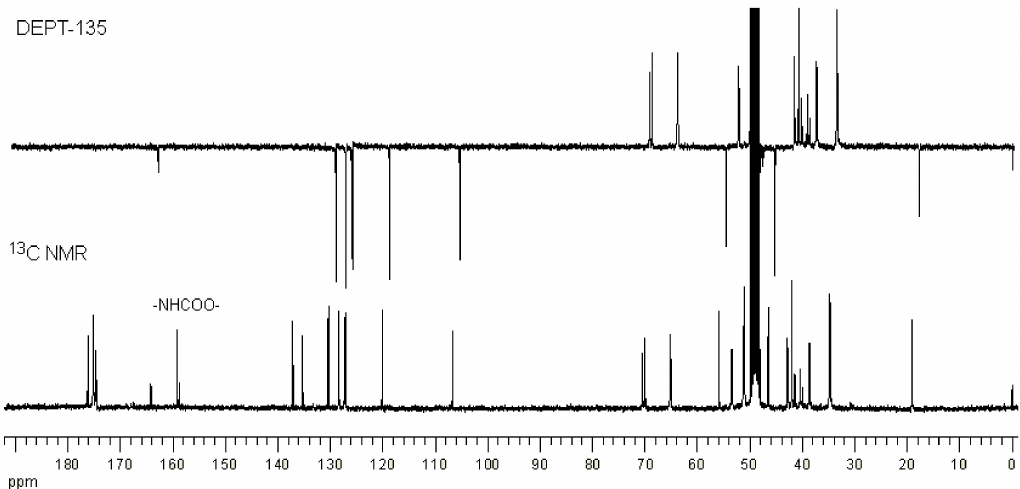
Figure 5. 13 C-NMR and DEPT-135 ( d 4 -MeOD) spectra of